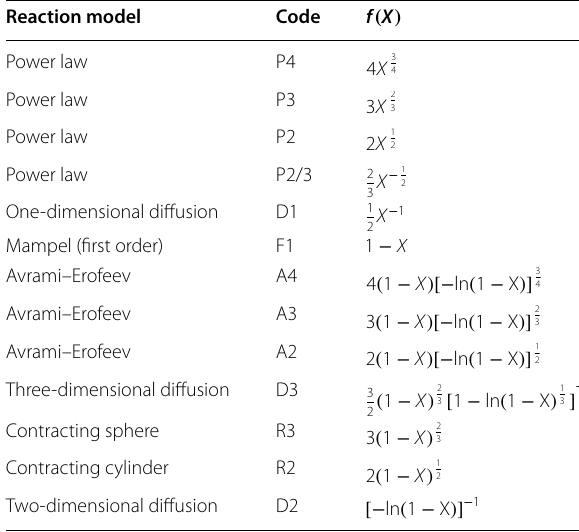
Table 10 The kinetic models of f ( X ) [187] Reaction